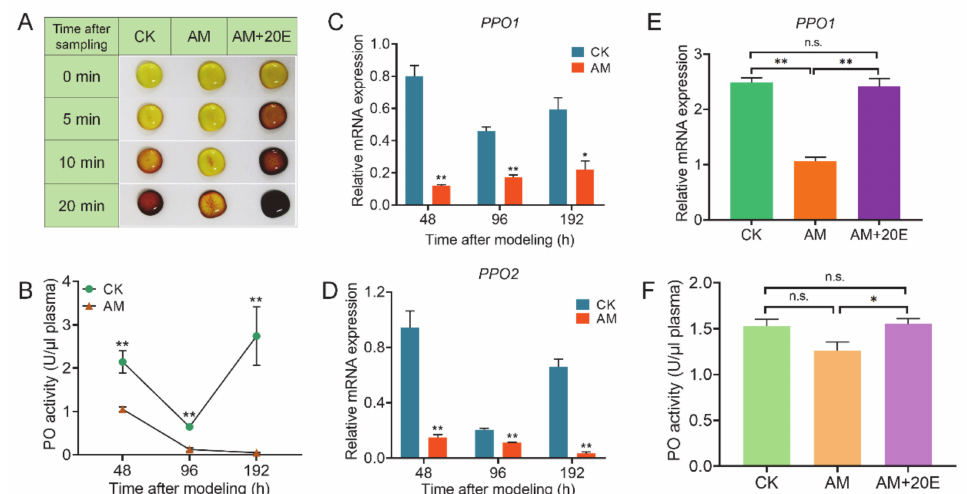
Figure 6. The melanization of hemolymph was inhibited by high PPC in silkworm after modeling and could be rescued by exogenous 20E. CK, the control group; AM, animal model of hyperproteinemia in which hyperproteinemia was induced at the wandering stage; AM+20E, the larvae of the AM were rescued by injecting 4 µ g of 20E at 24 h after the induction of hyperproteinemia. ( A ) Melanization speed in vitro of hemolymph. ( B ) Phenoloxidase (PO) activity in hemolymph. ( C , D ) The mRNA levels of PPO1 and PPO2 in hemocytes. ( E ) The mRNA levels of PPO1 in hemocytes at 48 h. ( F ) PO activity in hemolymph at 48 h after modeling. * p < 0.05; ** p < 0.01; n.s., no significant difference between the two groups. Mean ± SEM. n =